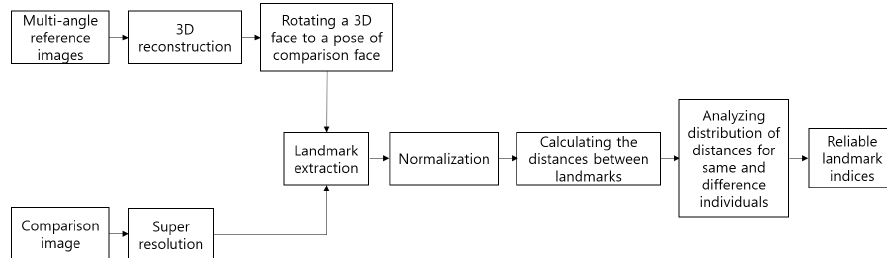
Figure 1. Overall framework of the proposed